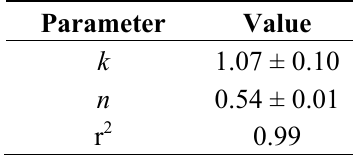
Table 3. Fick model n and k values for rehydrated WEAX